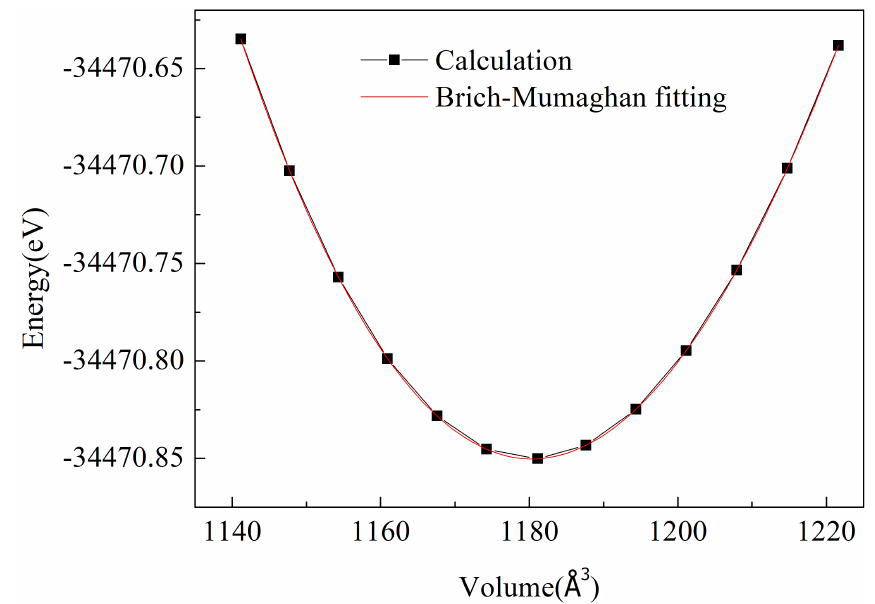
Figure 2. Conventional β -Mg 17 Al 12 cell volume as a function of the predicted total energy fluctua- tion